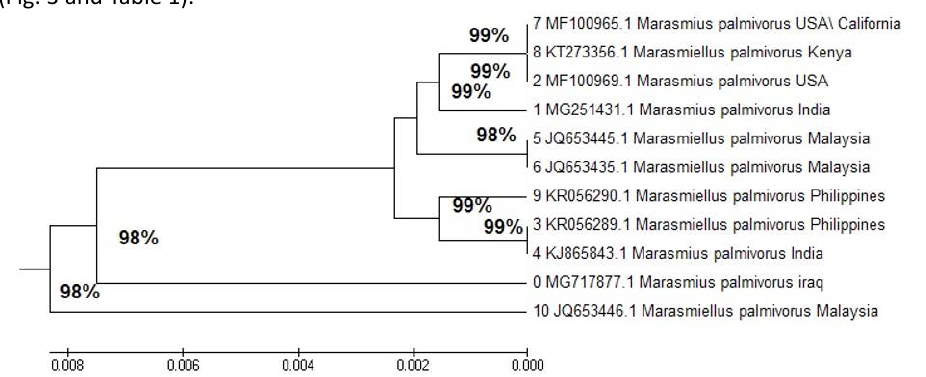
Fig. 3. Phylogenetic tree, depicting the relationship of M. palmivorus